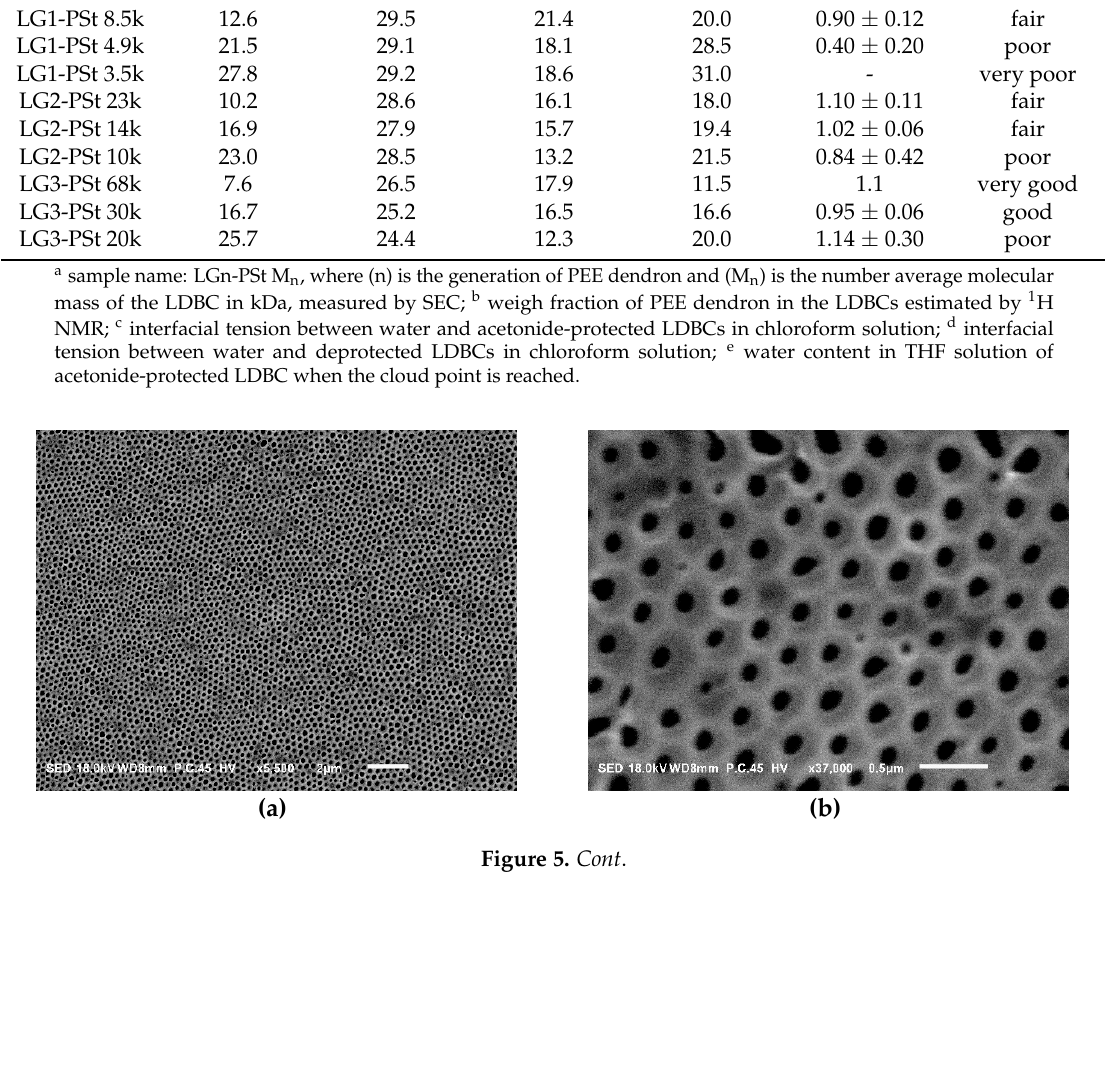
Table 1. Summary of BF film surface morphology produced by LDBCs. Sample a